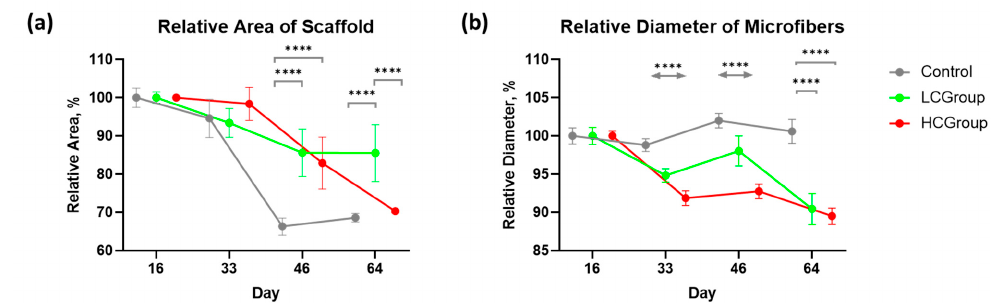
Figure 3. Changes in the implanted scaffolds in the control group and in groups modified with different concentrations of the VEGF165 plasmid: ( a ) Relative area of implanted scaffolds and ( b ) relative diameter of fibers in implanted scaffolds. Data presented as mean ± 95%CI. Note: **** p < 0.0001. Analysis of the decrease of relative area of microfibrous samples showed that the resorption of the control samples was more intense compared to the LCGroup and the HCGroup on day 46 and compared to LCGroup on day 64 ( p -value < 0.0001) (Figure 3a, Table S5). However, in the HCGroup, there was a significant decrease in fiber diameter